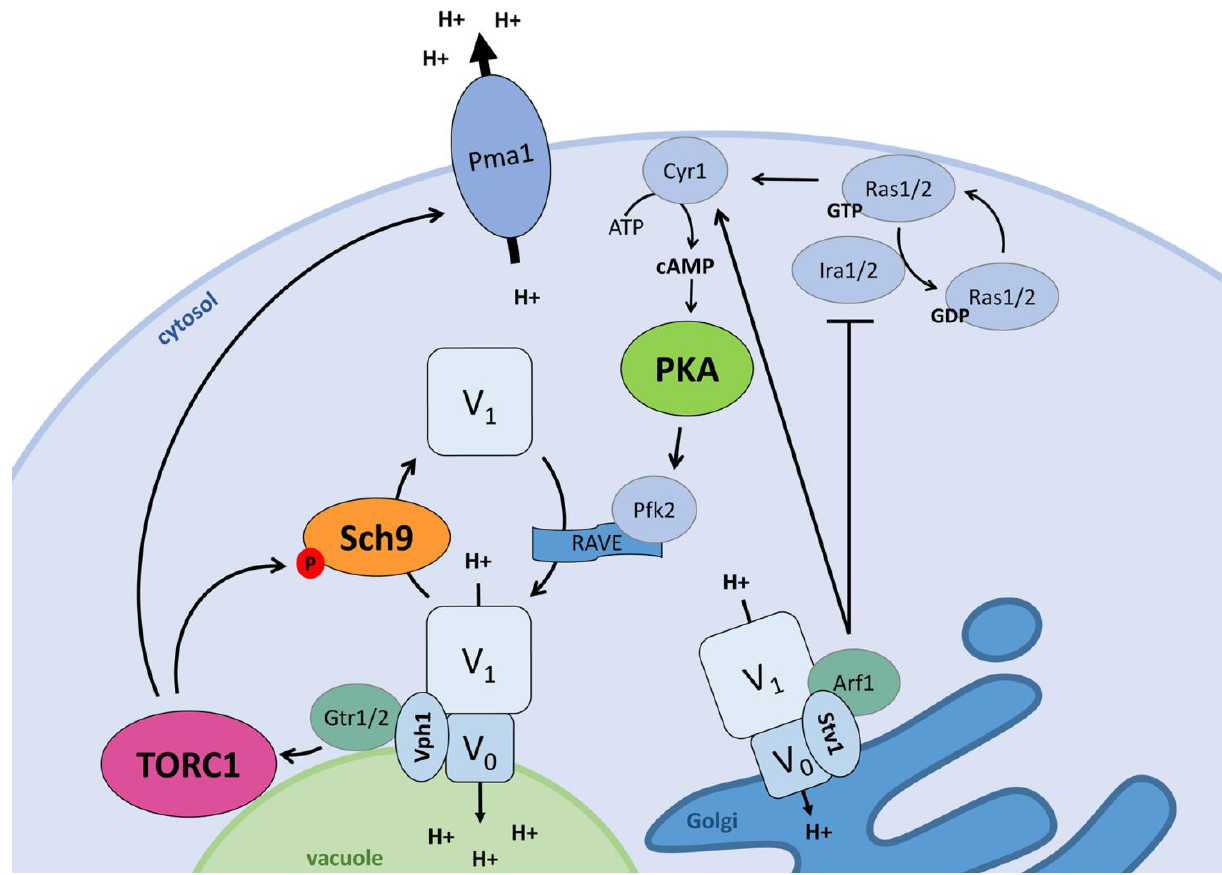
FIGURE 2: The interplay between signalling and pH control. Pma1 and the V-ATPase, the two main players in pH control, both impact and are regulated by the ménage-à-trois. When stimulated by glucose or cytosolic protons, the vacuolar Vph1-containing V-ATPase stimulates TORC1 via the EGOC-components Gtr1/2. The Golgi-specific Stv1-containing V-ATPase stimulates PKA via Ira1/2 inhibition by Arf1, pushing Ras1/2 towards the GTP-bound state and in turn activating Cyr1 to produce cAMP. Active TORC1 and PKA each regulate the vacuolar V- ATPase assembly state. TORC1 stimulates disassembly via Sch9, while PKA aids V-ATPase assembly presumably via Pfk2 which impacts on the V-ATPase scaffolding complex RAVE. Additionally, the vacuolar V-ATPase subunit Vph1 acts as a proton sensor to induce V-ATPase activi- ty, and this may also be the case for the Stv1-containing V-ATPase. Additionally, active TORC1 also stimulates Pma1